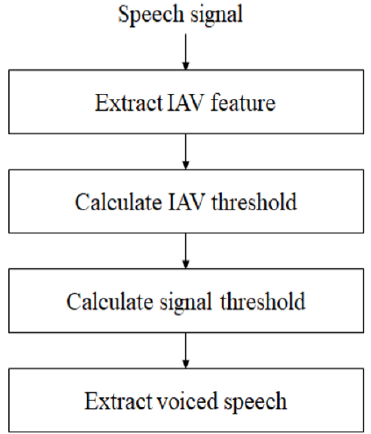
Figure 3. Flowchart of preprocessing